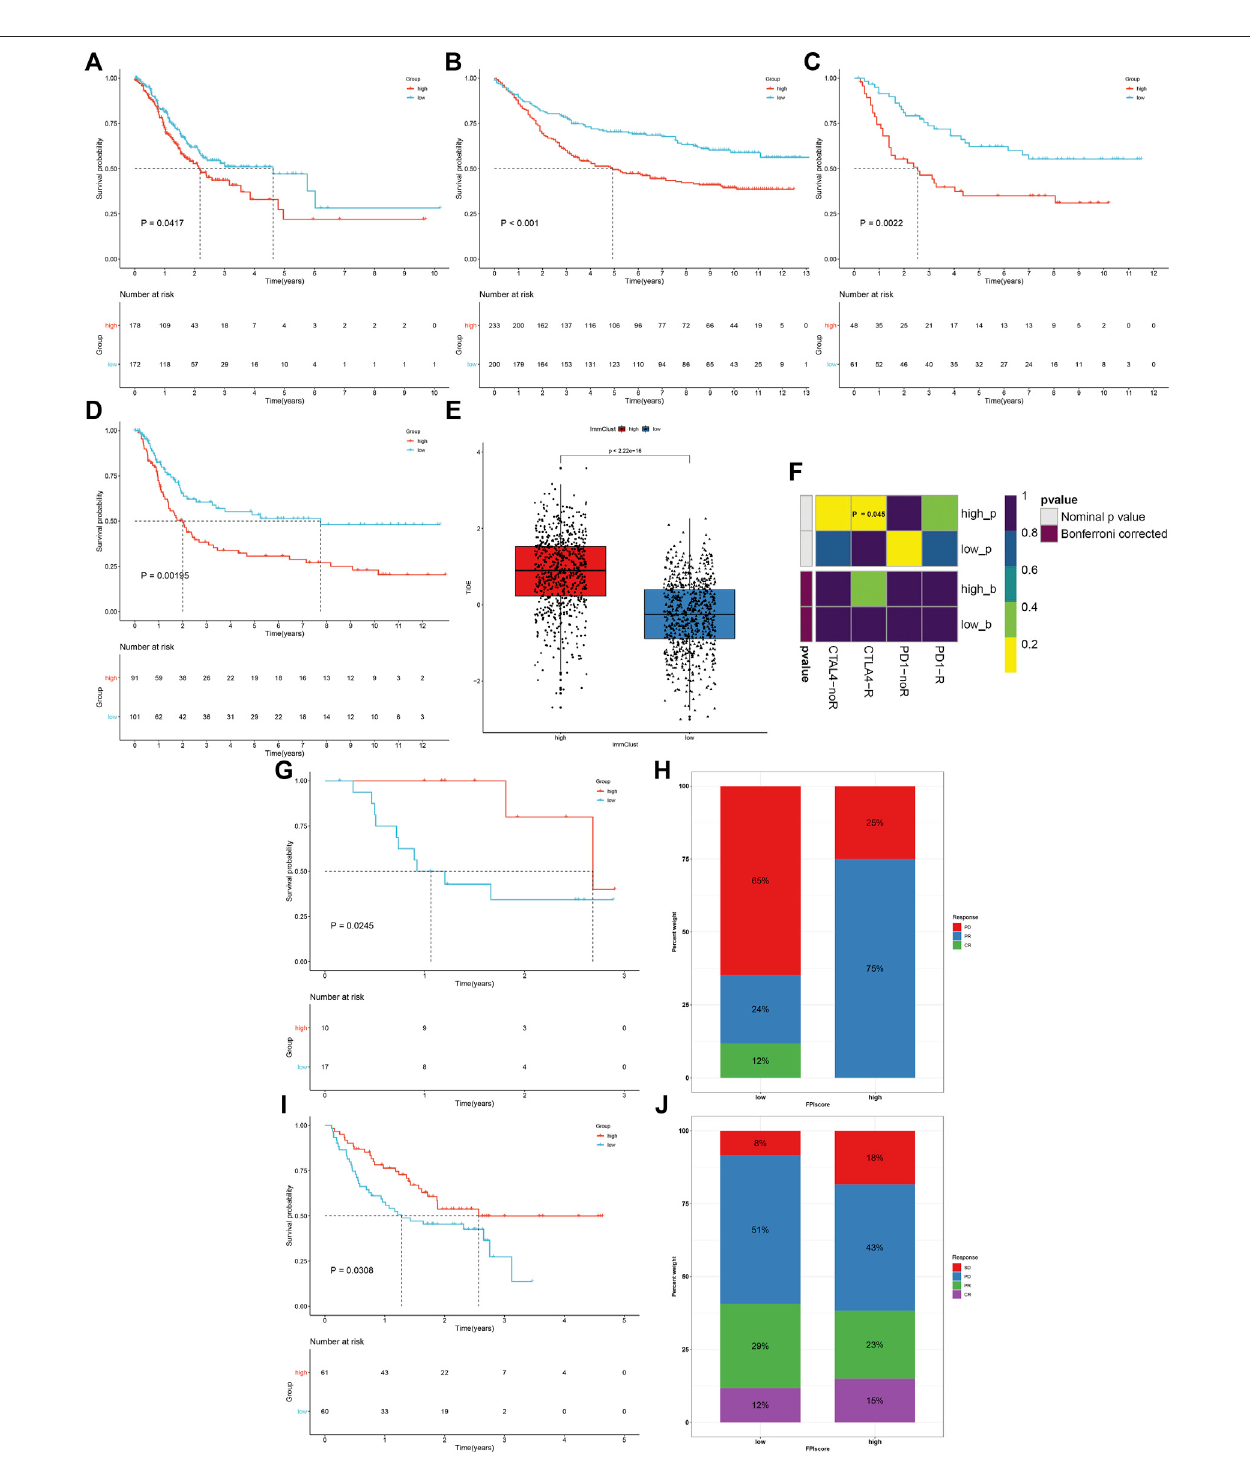
FIGURE 7 | FPI score serves as a predictor of immune response. (A – D) Survival analysis of GC patients with high and low FPI scores in the TCGA-STAD, GSE84437, GSE26901, and GSE15459 cohorts. (E) Comparison of the TIDE score in high and low FPI score groups. (F) SubMap analysis estimating the response to anti-CTLA-4 and anti-PD-1 therapy for high and low FPI patients. (G,H) Comparison of survival outcomes and therapeutic response to anti-PD-1 therapy between high and low FPI patients in the GSE78220 cohort. (I,J) Comparison of survival outcomes and therapeutic response to anti-PD-1 therapy between high and low FPI patients in the Liu et al.